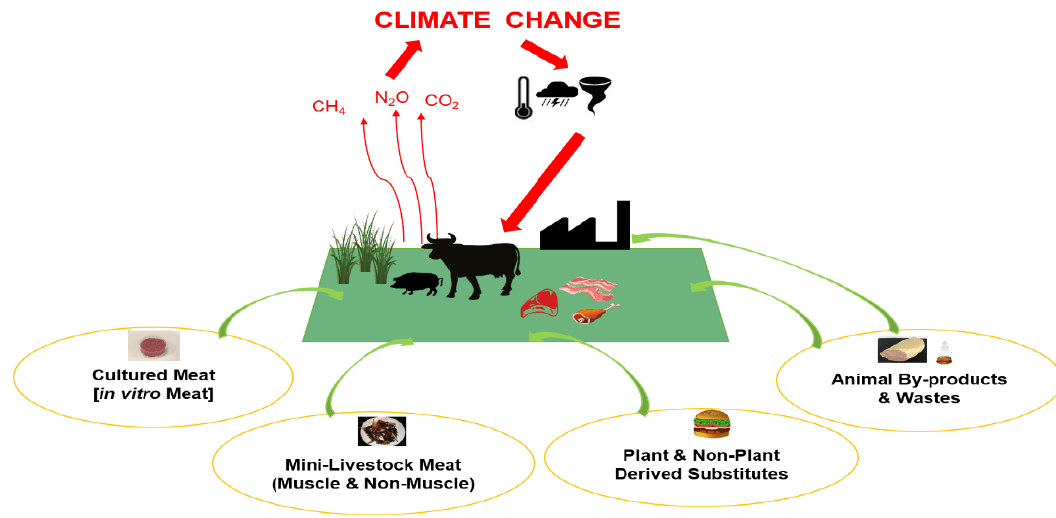
Figure 1. Livestock meat substitution strategies for the mitigation of climate change.